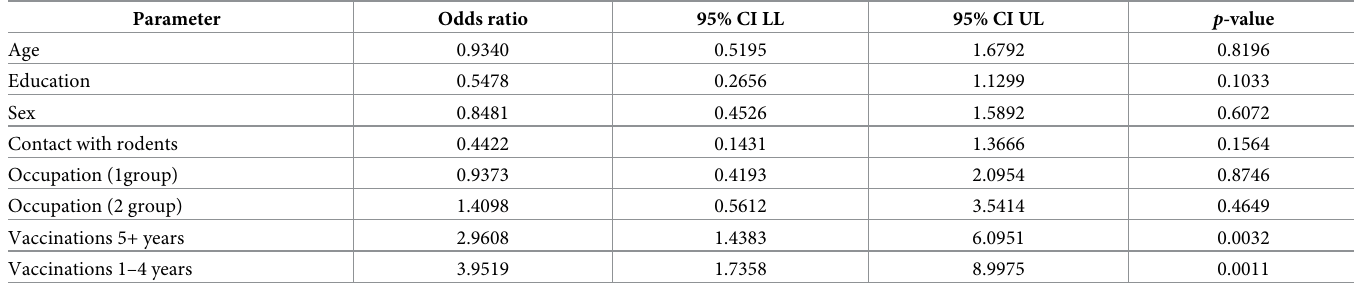
Table 6. Multivariate regression analysis of the relationship between proposed variables and serum antibodies to F1 Y . pestis 8 months after the vaccination.